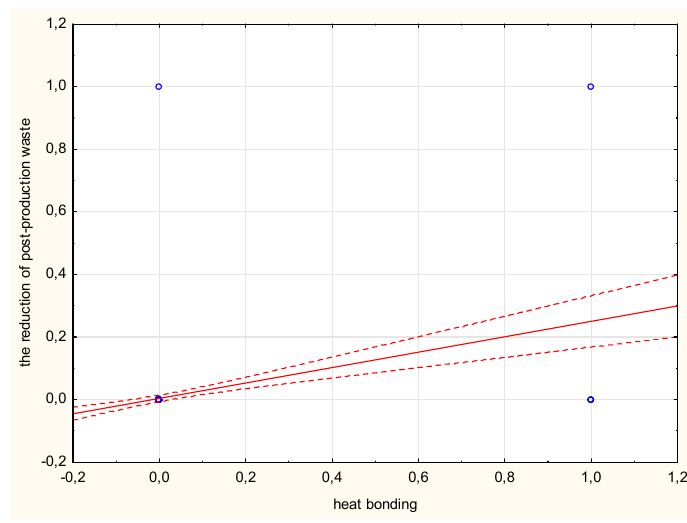
Figure 8. Interactions between the use of heat bonding and the reduction of post-production waste.